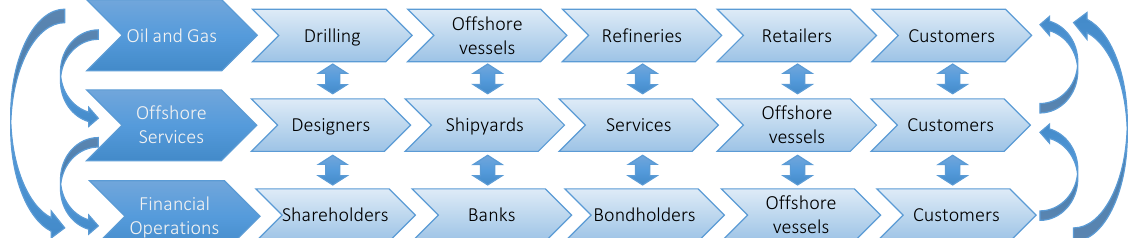
Figure 2. Supply chains related to offshore maritime